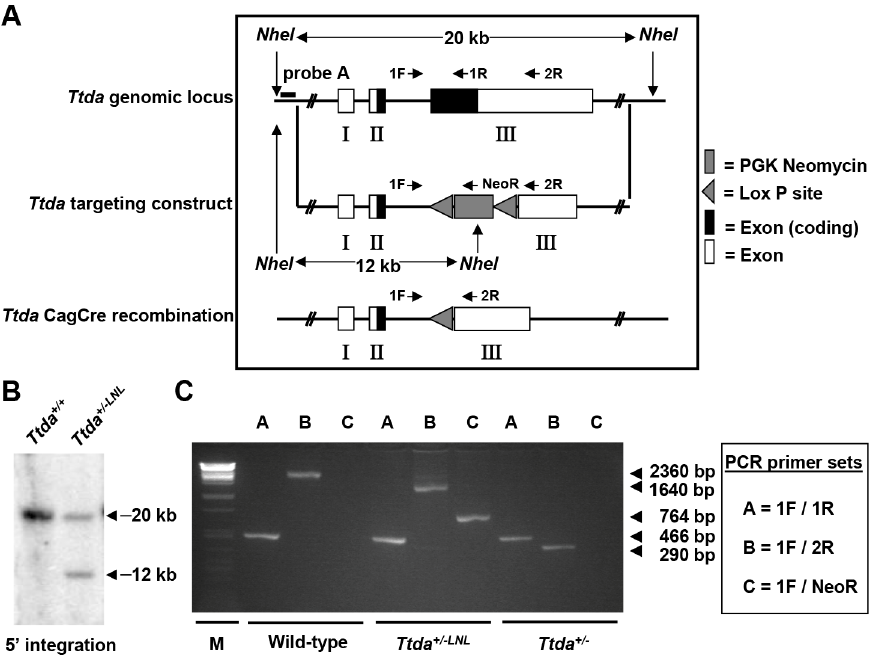
Figure 1. Generation of Ttda knock-out mice. (A) Schematic presentation of the mouse Ttda genomic locus, Ttda targeting construct and Ttda locus after CagCre recombination. Roman numbered boxes represent exons: white boxes are non-coding exon (parts) and black boxes are coding exon (parts). In the targeting construct LoxP sites are indicated with gray arrows and the dashed box represents the Neomycin selectable marker driven by a PGK promoter. The positions of NheI restriction sites, size of the NheI restriction fragments and the position of probe A used for DNA blot screening of digested ES cell DNA are indicated. The short arrows indicate the position and direction of primers used for genotyping. (B) DNA blot analysis of NheI-digested ES cell DNA using the probe A. (C) Genotype analysis with diagnostic PCR using primers 1F, 1R, 2R and NeoR in the different combinations (A, B and C).